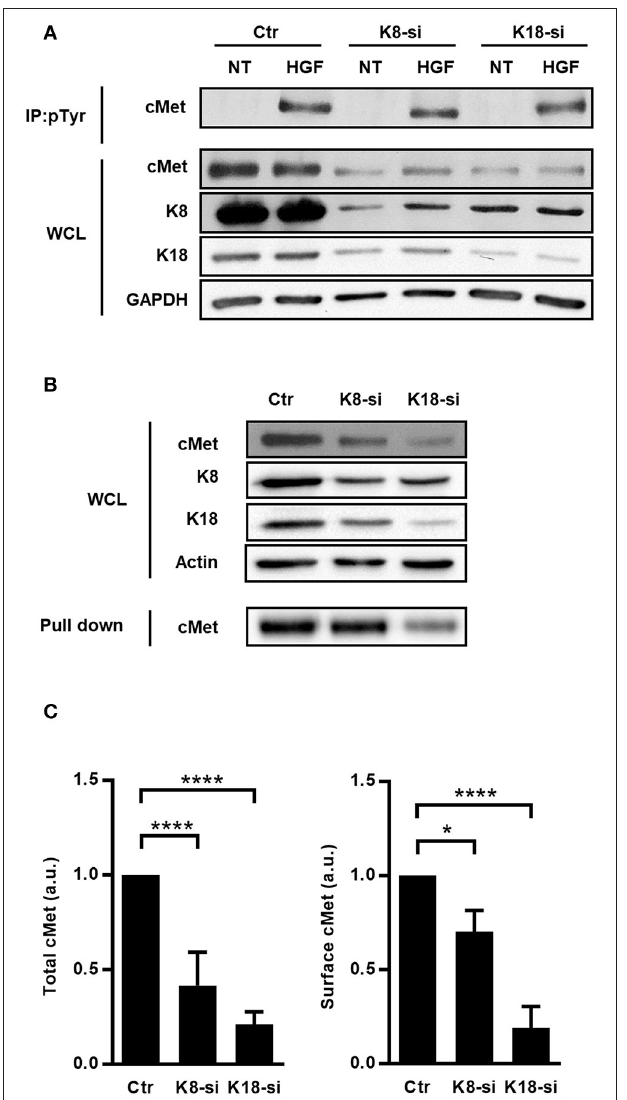
FIGURE 5 | Total expression, surface localization and activation of cMet are perturbed in cells expressing low levels of K8 and K18. (A) HeLa cells transfected with Ctr, K8, and K18-targeting siRNAs were left untreated (NT) or incubated with 150ng/ml HGF for 5min, washed and lysed. Tyrosine phosphorylated proteins were immunoprecipitated (IP: pTyr) from whole cell lysates (WCL) and cMet was analyzed by immunoblot (cMet) in IP fractions and WCL. GAPDH detection was used as loading control. (B) Surface exposed proteins of control (Ctr), K8- (K8-si), and K18-depleted (K18-si) HeLa cells were biotinylated and recovered from total cell extracts following neutravidin pull down assays. Biotinylated samples, corresponding to surface exposed proteins, and whole cell lysates (WCL) were immunoblotted to detect cMet, K8, K18 and actin. (C) Quantifications of cMet in WCL (left panel) and in biotinylated samples (right panel) from at least three independent experiments. Statistically significant differences are indicated: * p < 0.05 and **** p < 0.0001 (a.u., arbitrary units).